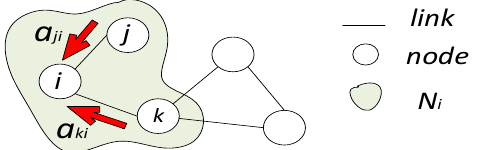
Figure 16. Network Structure of the Communication Layer.